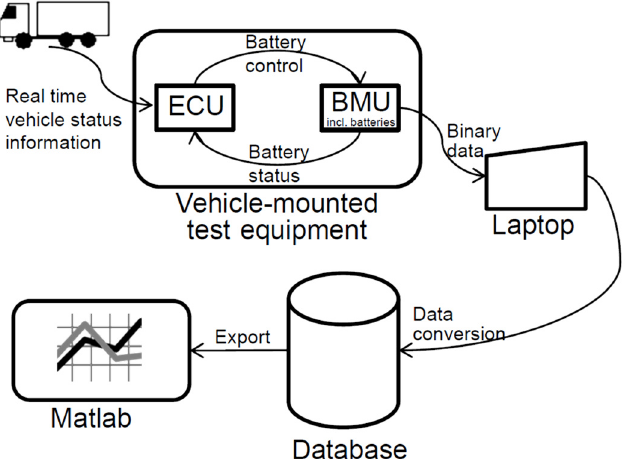
Figure 1. Flowchart describing the field test data collection. The electronic control unit (ECU) communicates with the vehicle and calculates and sends cell cycling data to the battery management unit (BMU). The cycled cell and the reference cell are physically placed in the vicinity of the